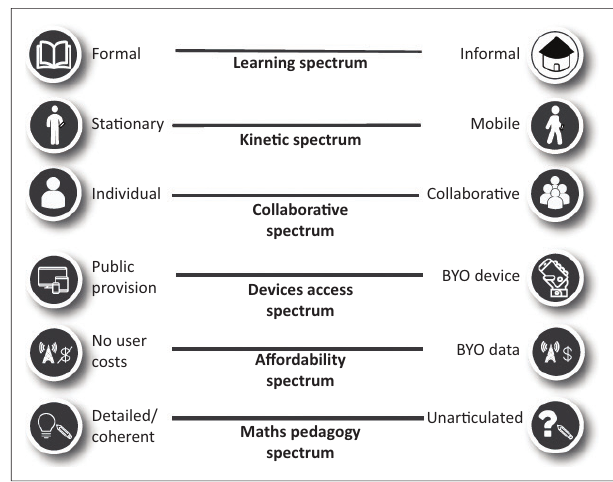
Figure 1 summarises the m-learning configurations.